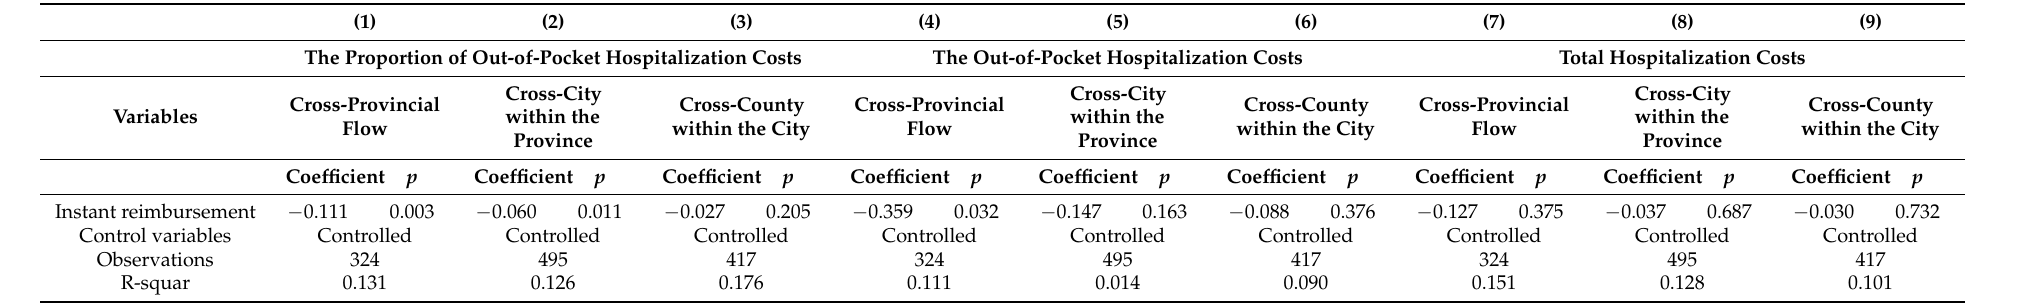
Table 5. The regression results for the impact of cross-regional reimbursement of medical services on the hospitalization costs under different flow